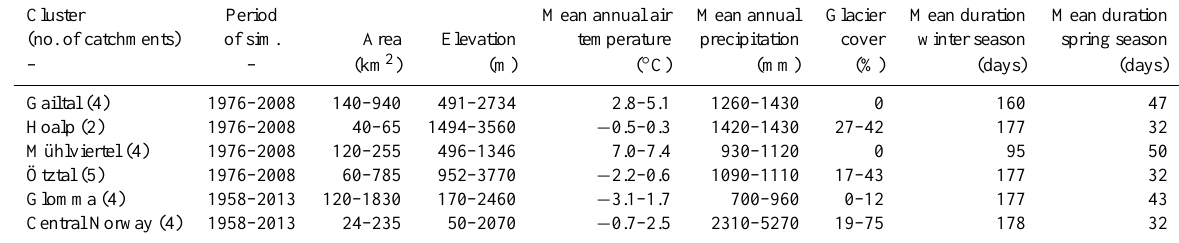
Table 2. Catchment characteristics of selected catchments in Austria and Norway, per cluster (min–max per catchment). Cluster